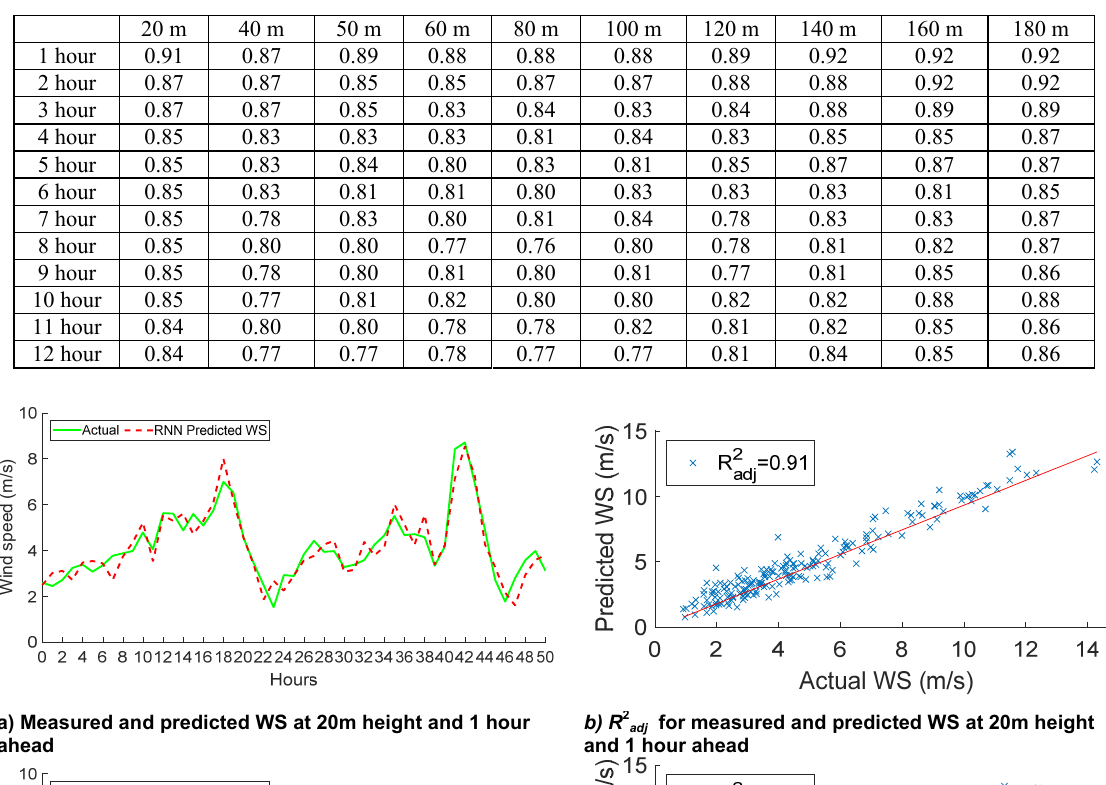
Table 3. Adjusted coefficient of determination ( R 2 adj ) at different heights and different prediction hours.